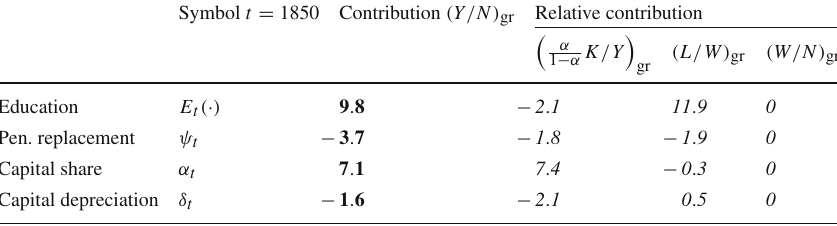
Table 5 Contribution of other factors to per-capita income growth ( Y / N ) gr from 1850 to 2000 (in percent) Source Authors’ estimates Symbol t = 1850 Contribution ( Y / N ) gr Relative contribution